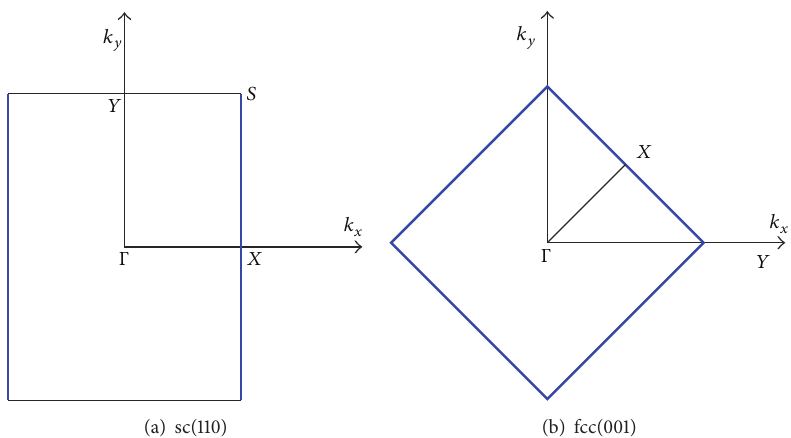
Figure 7: SBZ for (a) sc(110) and (b) fcc(001) surface cuts with the segments of the SBZ border at which the collapse of the bulk band occurs marked with bold blue